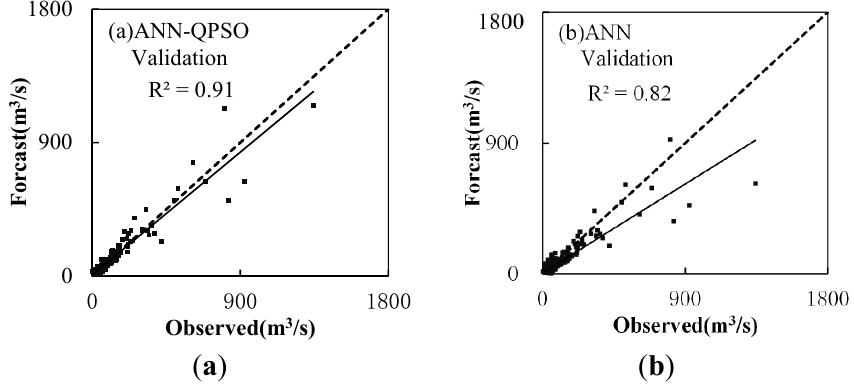
Figure 6. Scatter plots of observed data vs. forecasted data during the training period. ( a ) ANN-QPSO; ( b ) ANN.